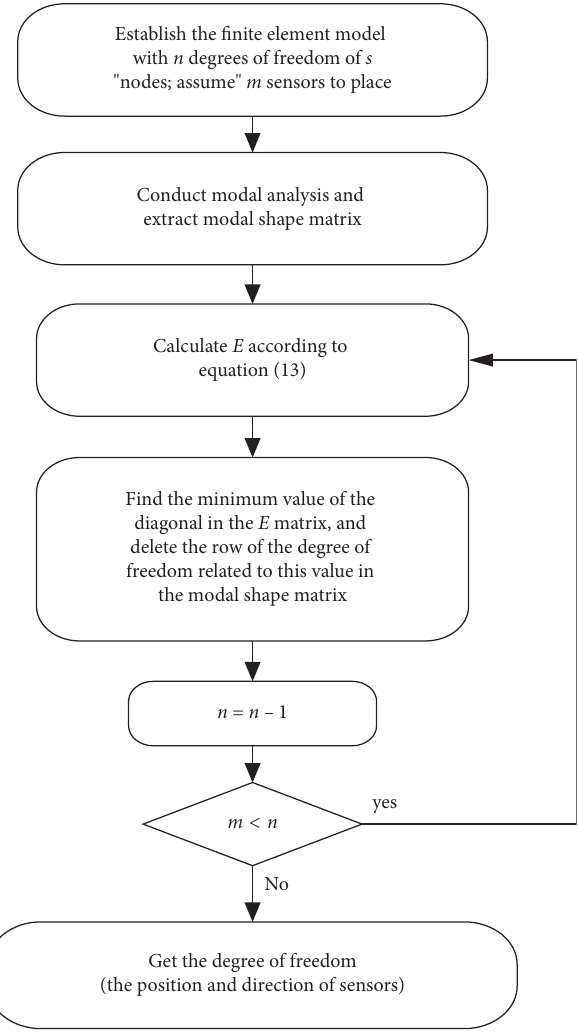
Figure 1: The process of EIM for optimal sensor